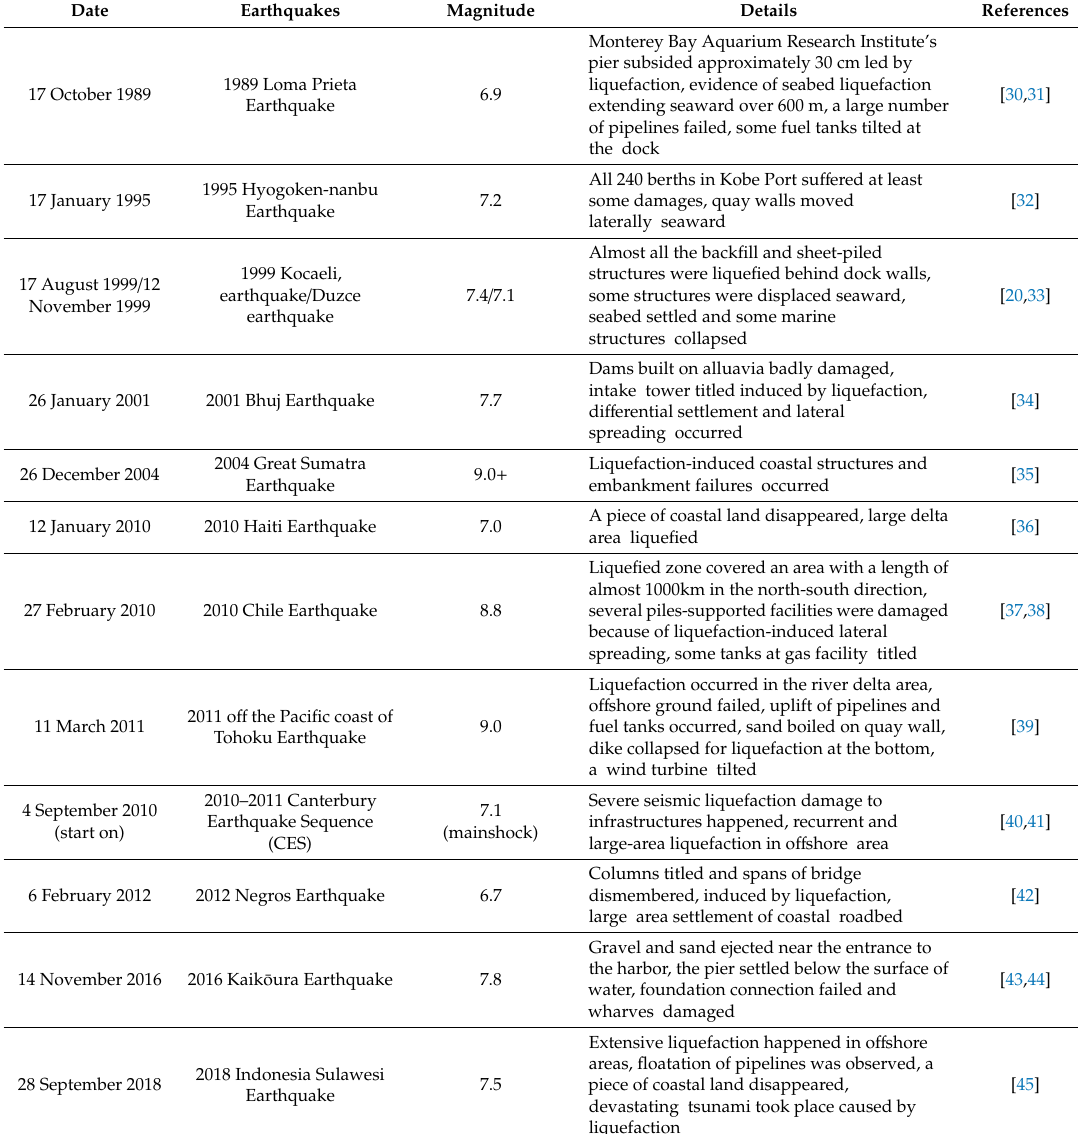
Table 1. Major historical cases of seismic liquefaction in marine